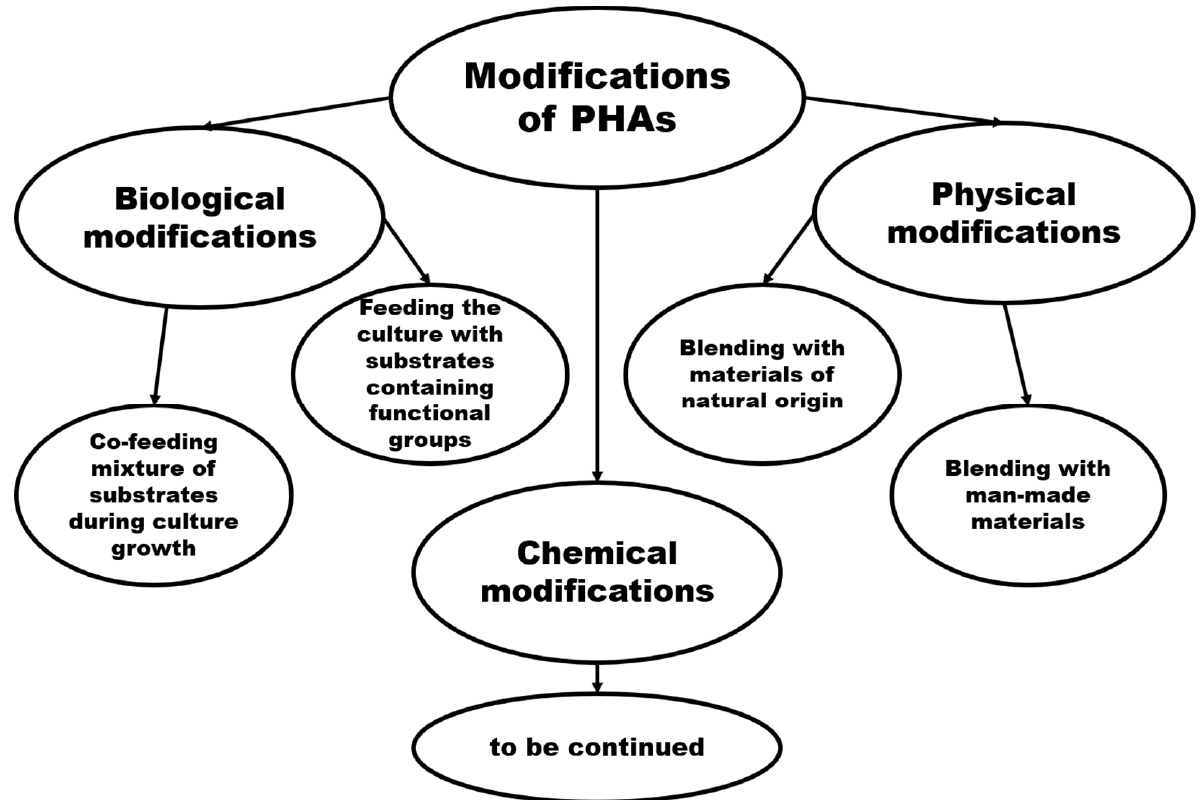
Figure 1. PHA modification methods.